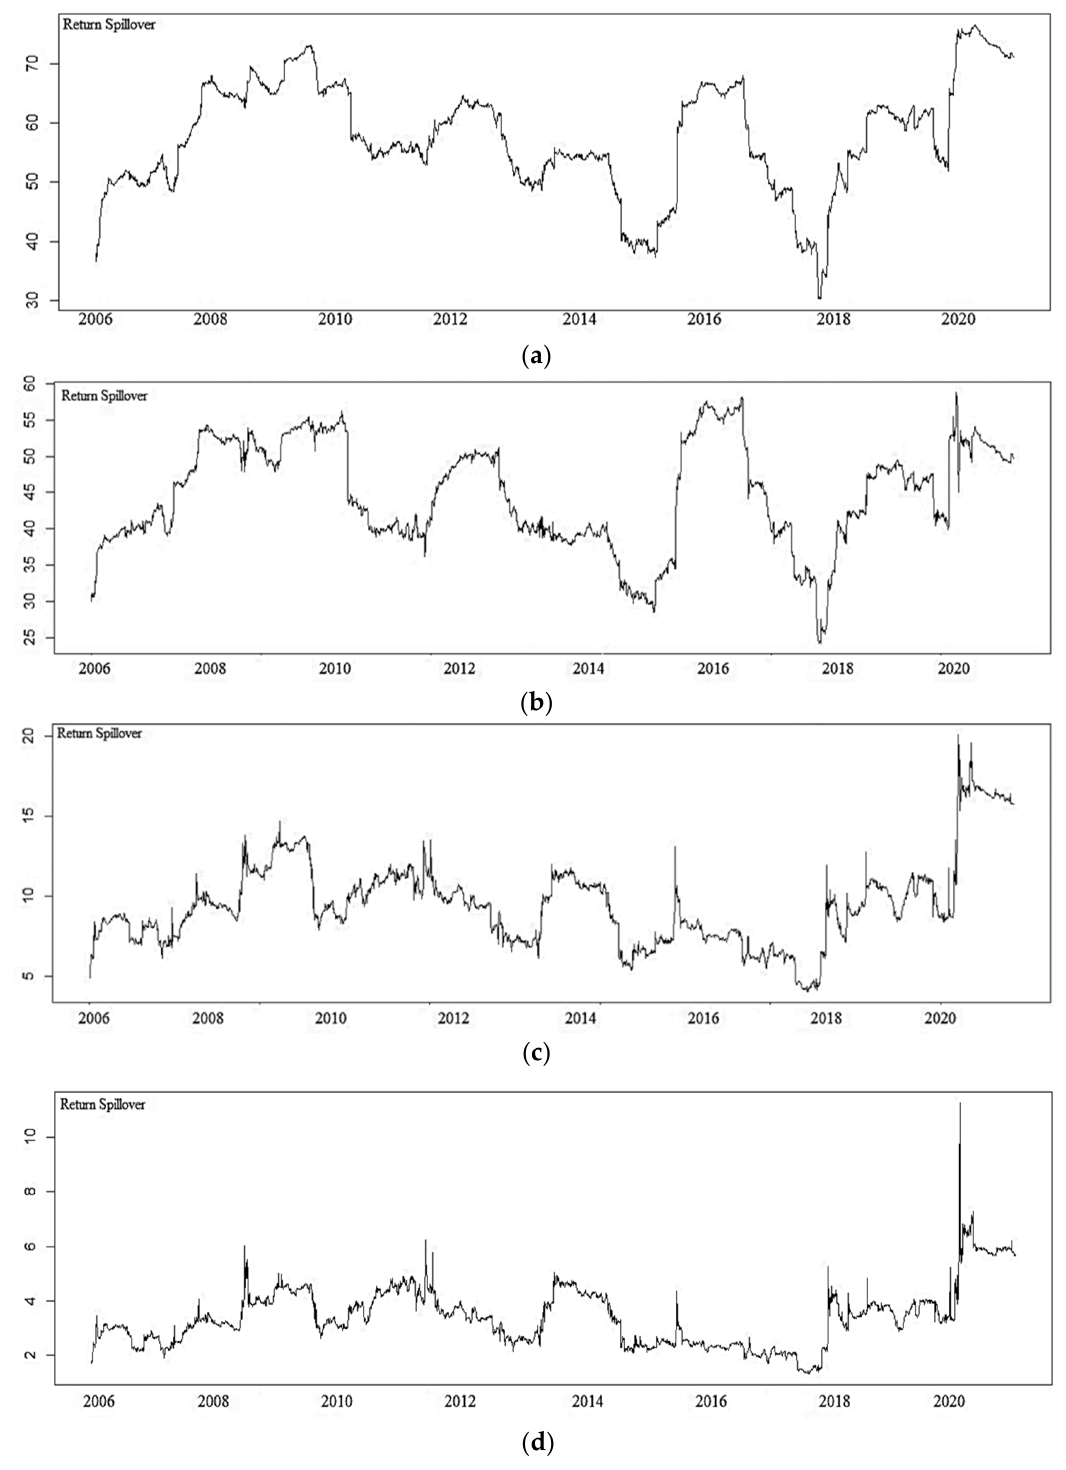
Figure 3. Distribution plots and pairwise correlations of asset returns for ASEAN+3. Return spillover based on the DY12 and BK18 methods: ( a ) Connectedness on asset return using DY12; ( b ) BK18 frequency domain for short-term (1 day to 5 days); ( c ) BK18 frequency domain for medium-term (from 6 days to 22 days); ( d ) BK18 frequency domain for long-term (22 days to infinity). The dynamic volatility connectedness is measured using a 200-day rolling window and a forecast horizon of H = 100 days.